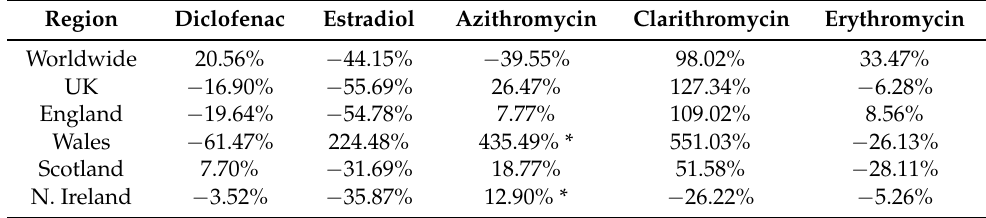
Table 4. Worldwide, UK, and Regional Percentage Differences between the Years 2004 and 2014. Region Diclofenac Estradiol Azithromycin Clarithromycin Erythromycin Worldwide 20.56%